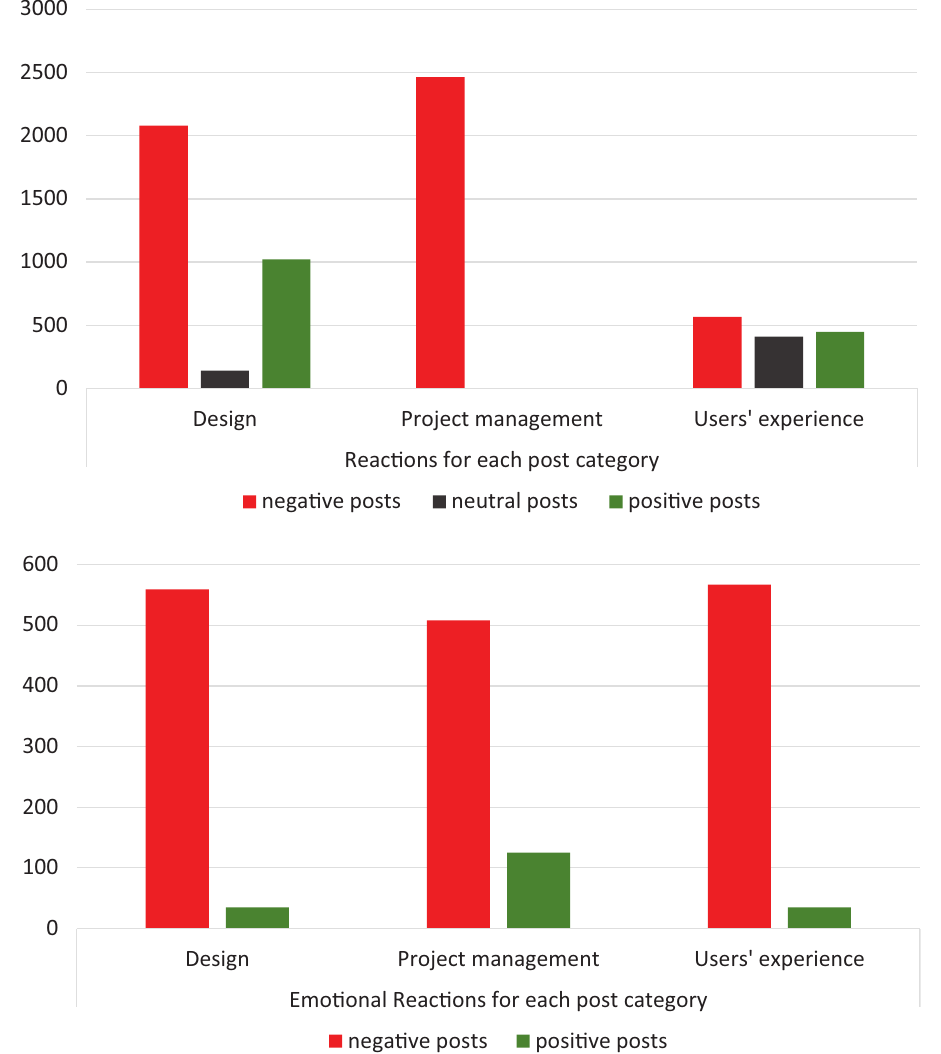
Figure 9. Moderate supportive reactions (likes) to the posts of Figure 8 (top) and strong supportive reactions (emotions) to the posts of Figure 8 (bottom).